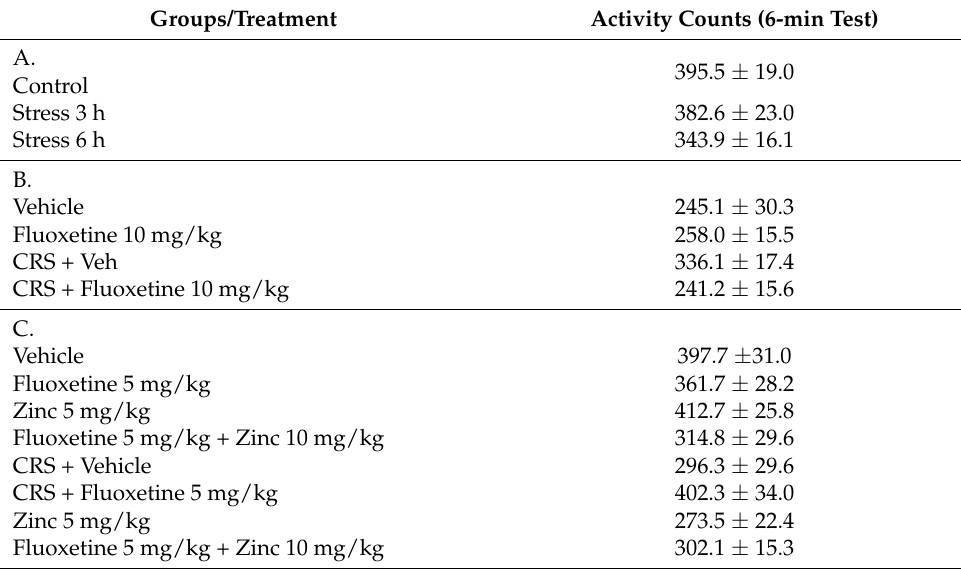
Table 1. Effect of CRS, FLU, or FLU + Zn treatment on the locomotor activity of mice.